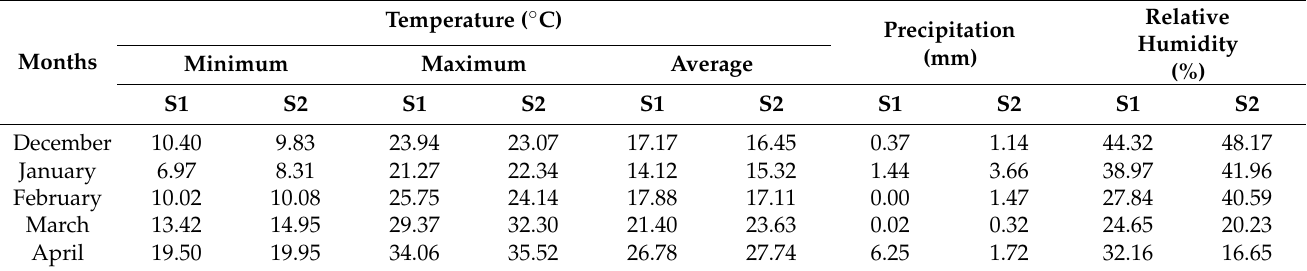
Table 1. Average monthly climatic data at the experimental site during the growing period of wheat in 2019-2020 (S1) and 2020-2021